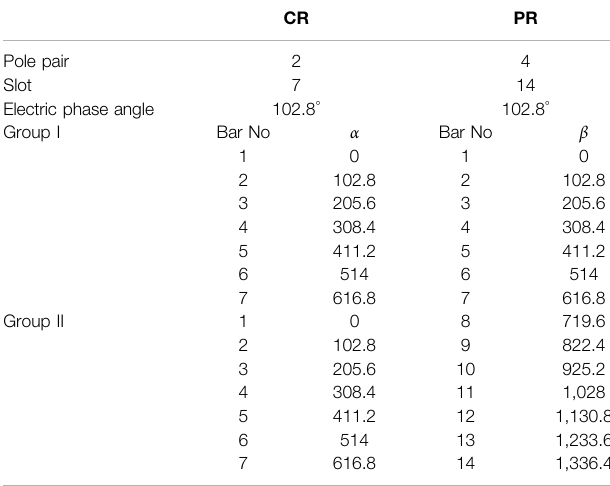
TABLE 2 | Interconnection between PR and CR bars under PR with 4 pole pairs and 14 slots, CR with 2 pole pairs and 7